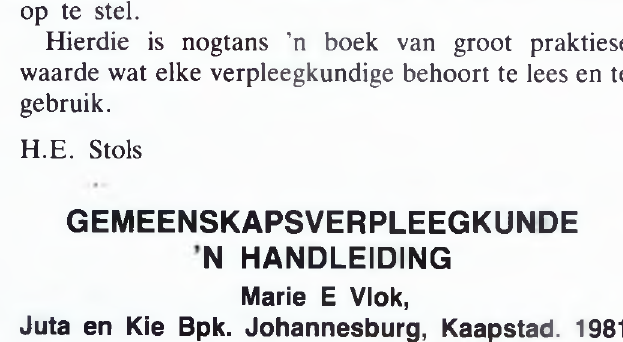
Die verpleegproses word ook op pasiëntonderrig en gesondheidsvoorligting toegepas. Die integrasie van m oderne tendense in gesondheid word weerspieël in die wyse waarop doelwitstelling in